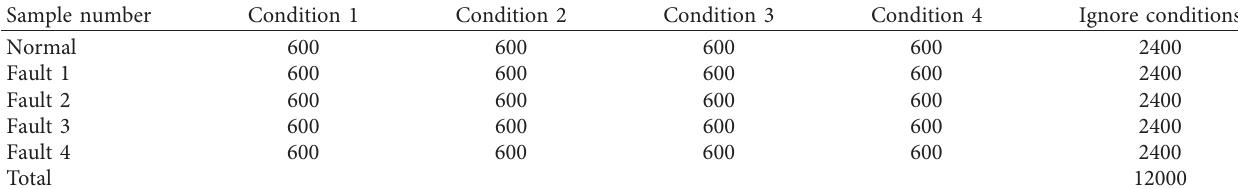
Figure 6: Physical diagram of fault simulation experimental platform. Table 1: Number of samples for different training methods.